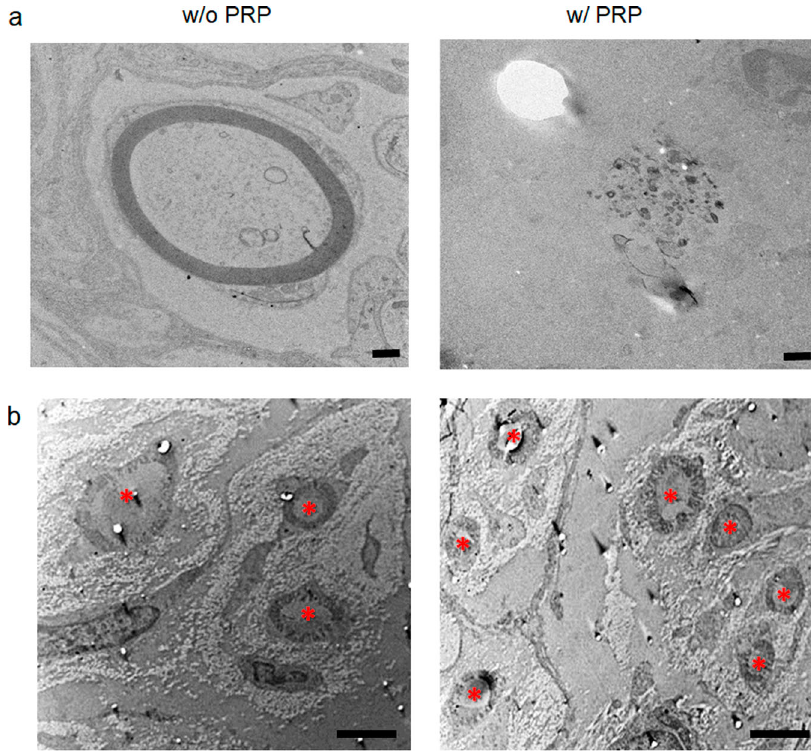
Fig. 8 Transmission electron microscopy (TEM) fi ndings at 8 and 16 weeks post-implantation. a TEM image at 8 weeks post-implantation (scale bar, 500 nm). b TEM images at 16 weeks pot-implantation (scale bar, 2 μ m). Asterisks indicates the axons. Myelinated fi ber formation was more abundant in the PRP group than in the non-loaded group. Axon fi bers in the PRP group at 16 weeks were denser and better organized with Schwann cells than at 8 weeks. NGC nerve guidance conduit, PRP platelet-rich